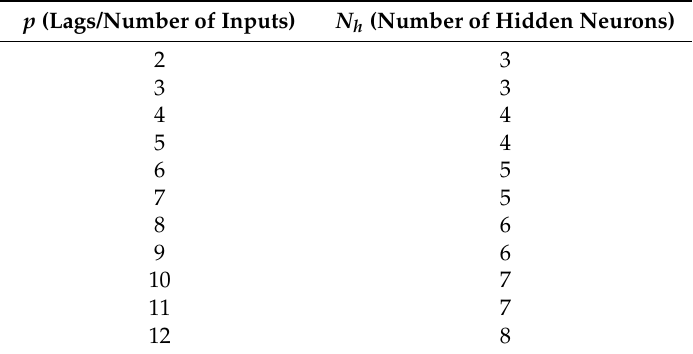
Table 2. Number of hidden neurons used with respect to every Lags/inputs of ANN. p (Lags/Number of Inputs)